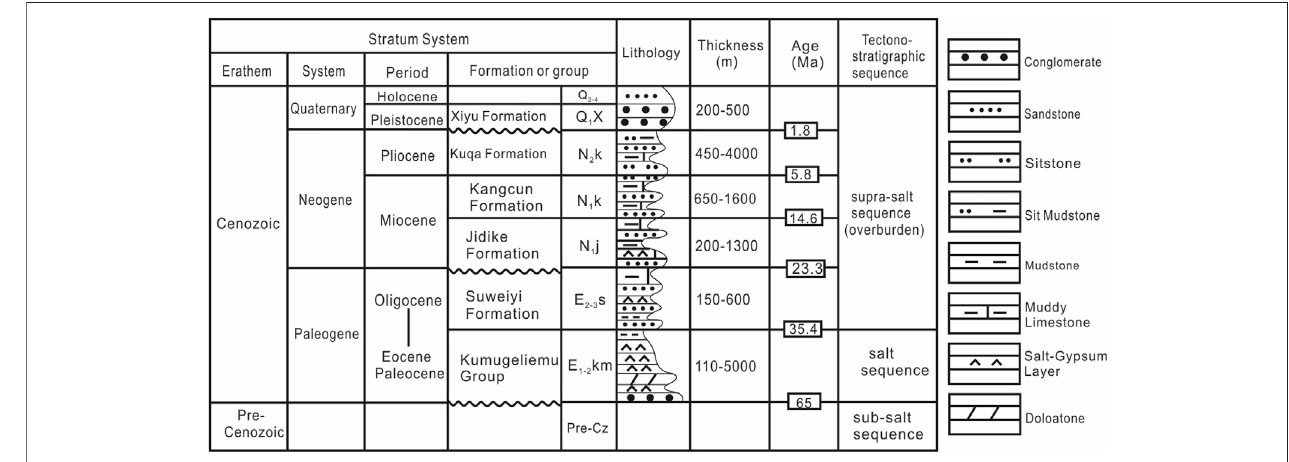
FIGURE 2 | Stratigraphy of the Kuqa Foreland Basin.